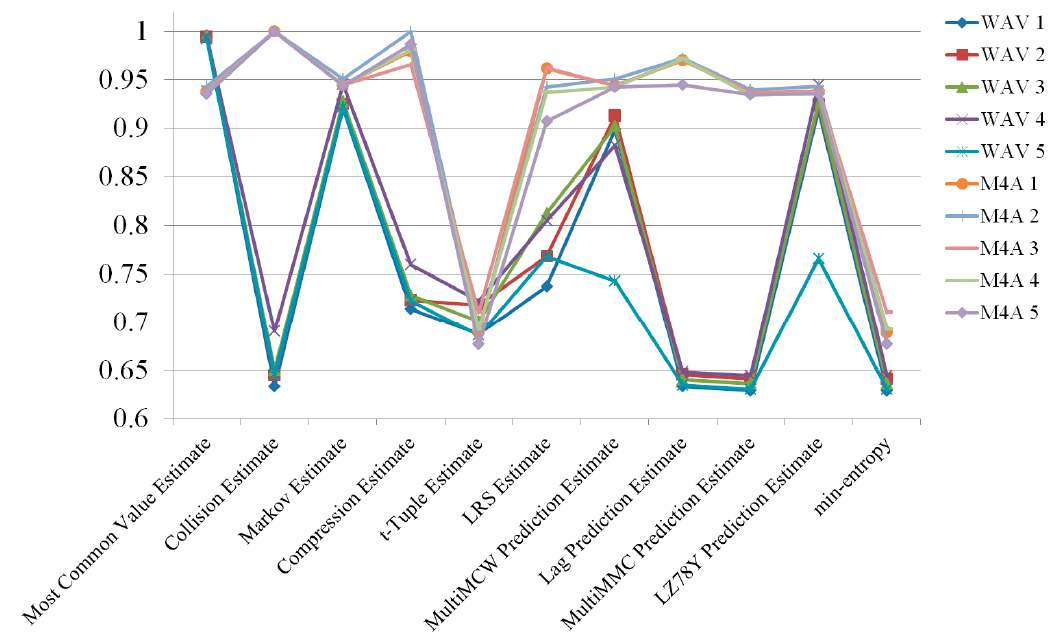
Figure 8. Randomness estimation results of the radio signals collected with 5 s delay.